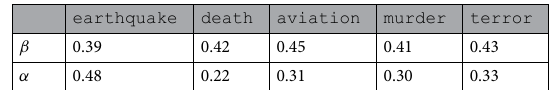
Table 4. Median of β and α for five categories for the proposed